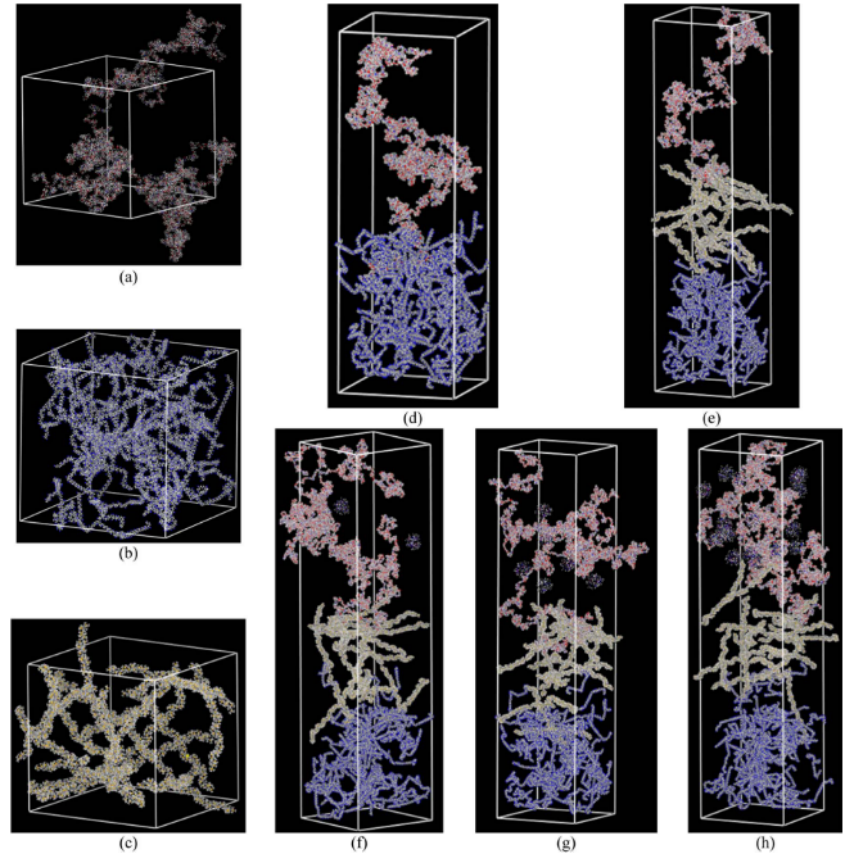
Figure 15. The final molecular configuration of amorphous cells of pristine membranes and nanocomposite polymeric membranes: ( a ) Pebax, ( b ) PAN and ( c ) PTMSP; composite polymeric membranes: ( d ) CPM2 and ( e ) CPM3 and nanocomposite polymeric membranes ( f ) NCPM3/ZIF8%, ( g ) NCPM3/ZIF22% and ( h ) NCPM3/ZIF34% [31].